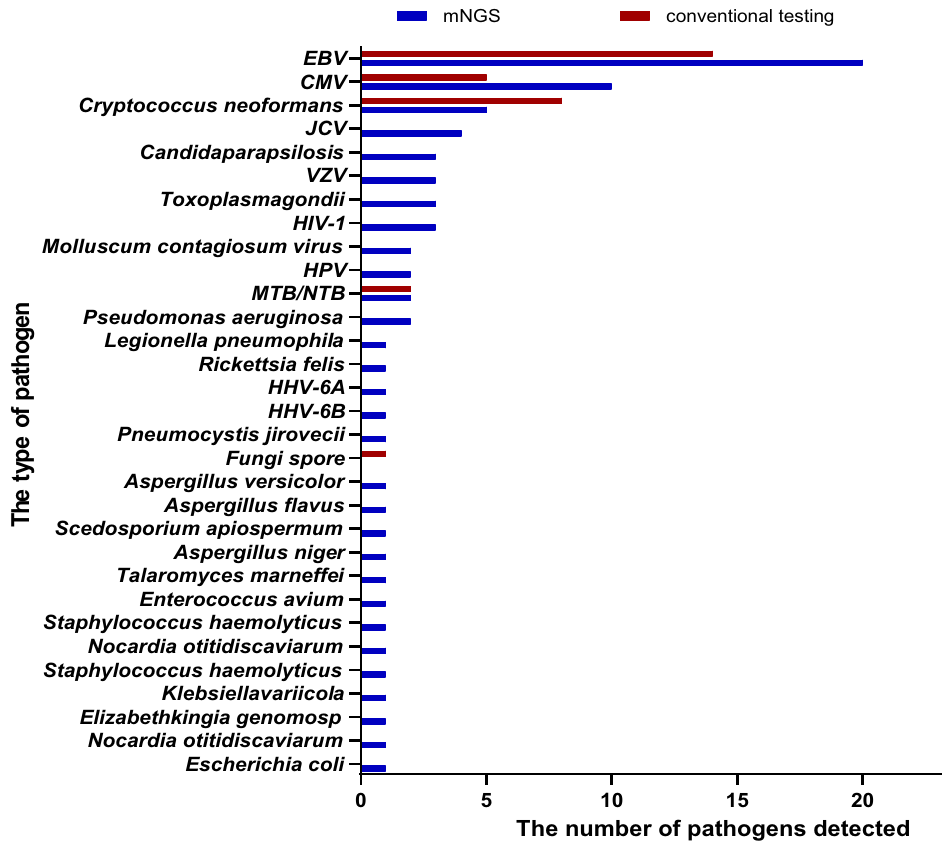
Figure 3. The distribution of pathogens types detected by two methods.